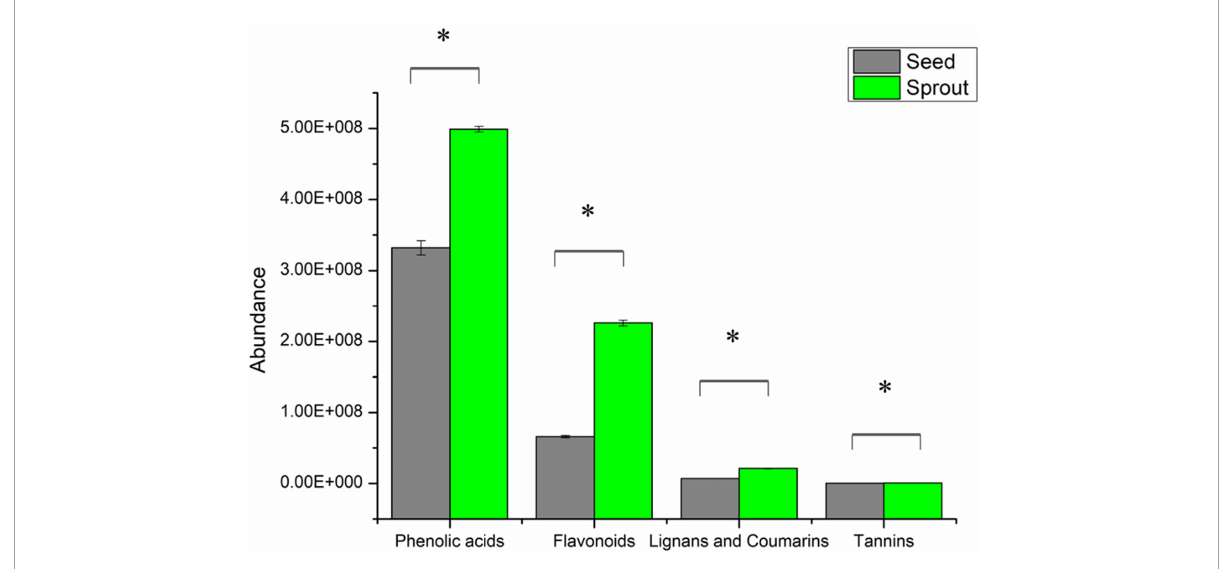
FIGURE3 The abundance of phenolic classes between white radish seed and sprout. ∗ Indicated significantly different ( P <